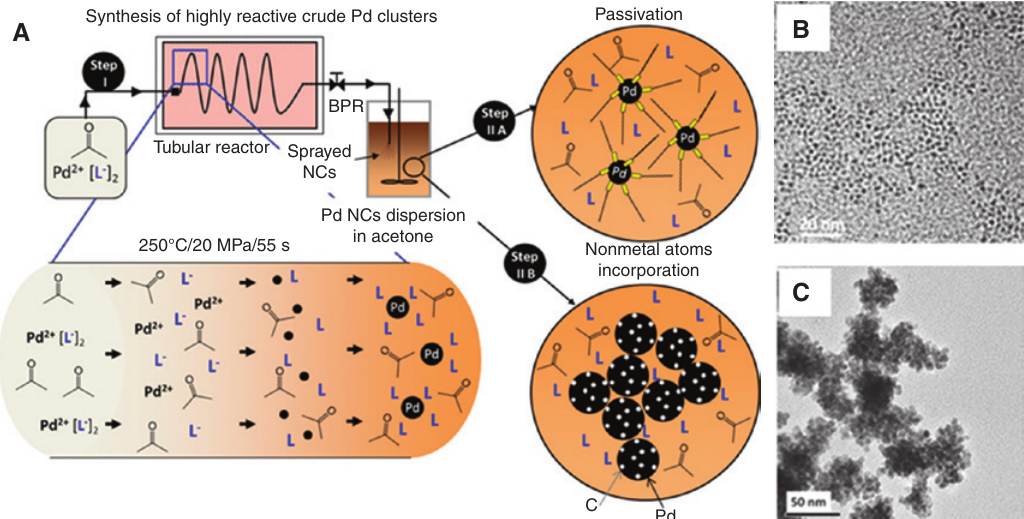
Figure 23: (A) Sketch of the continuous supercritical process for the synthesis of Pd NCs with separate control of the nucleation/growth and their subsequent surface modification. Reprinted with permission from Pascu O, Moisan S, Marty JD, Aymonier C, J. Phys. Chem. C 2014, 118, 14017–14025 [20], Copyright 2014 American Chemical Society. (B) TEM image of small thiol-capped Pd NCs and (C) naked Pd NCs forming aggregates in the absence of organic